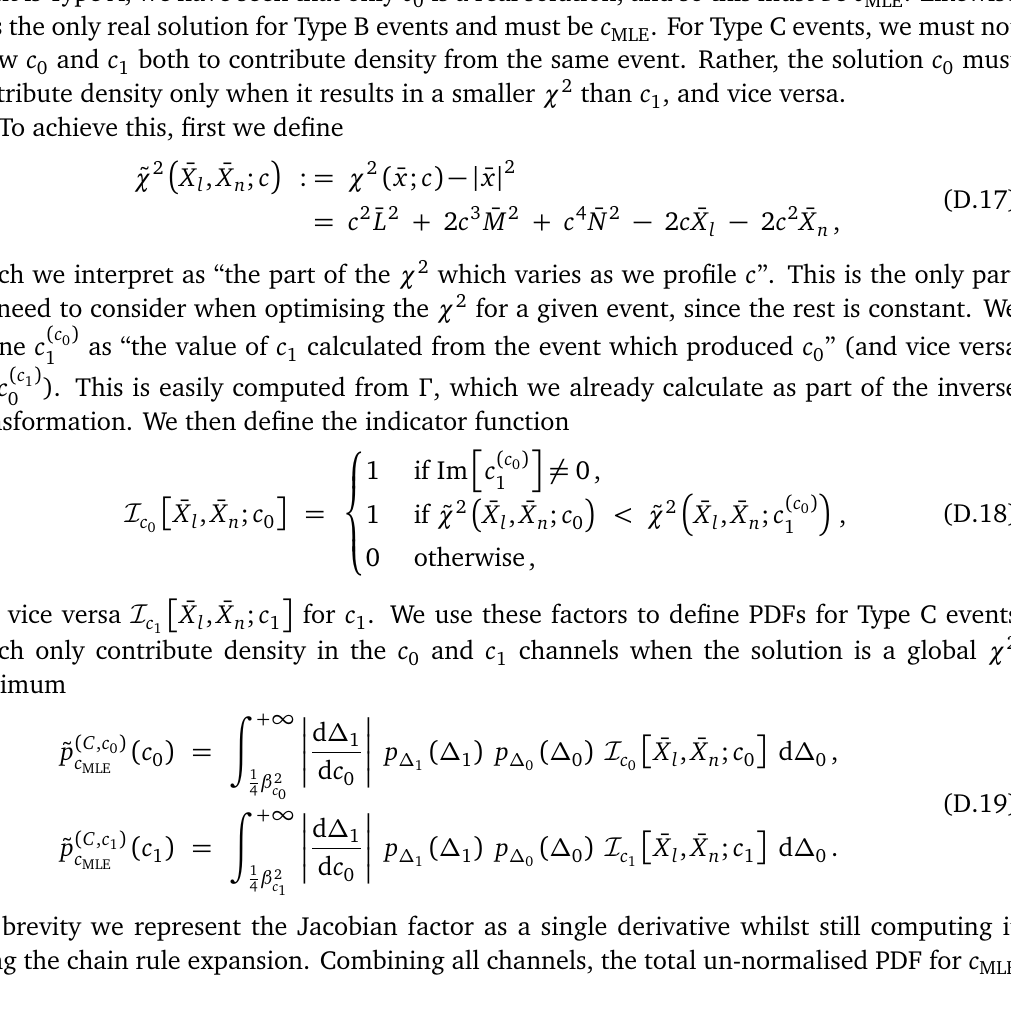
Figure 26: Densities of c on the real axis. Type A events are not considered because they fall in the complex